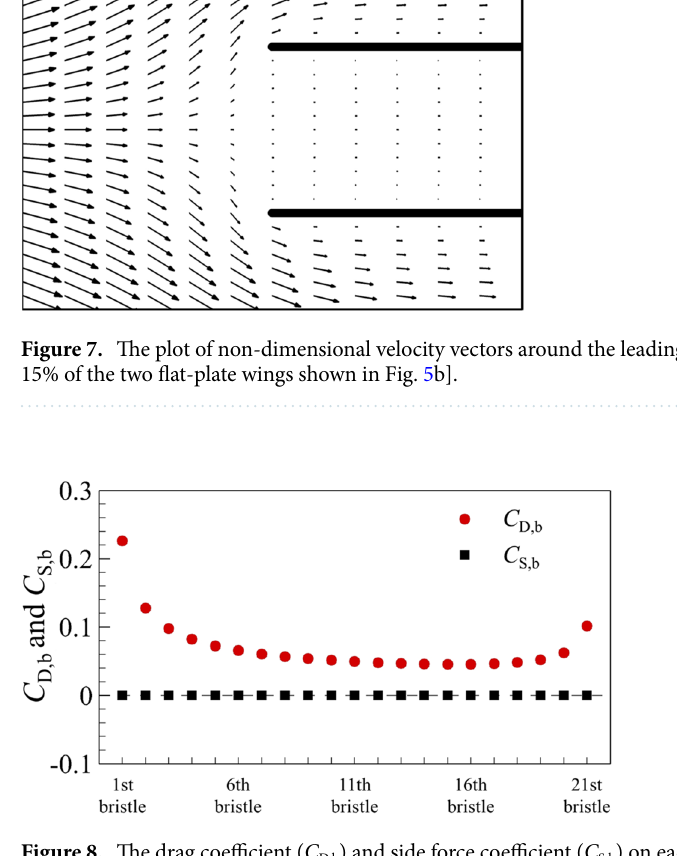
Figure 8. The drag coefficient ( C D,b ) and side force coefficient ( C S,b ) on each bristle of a single bristled